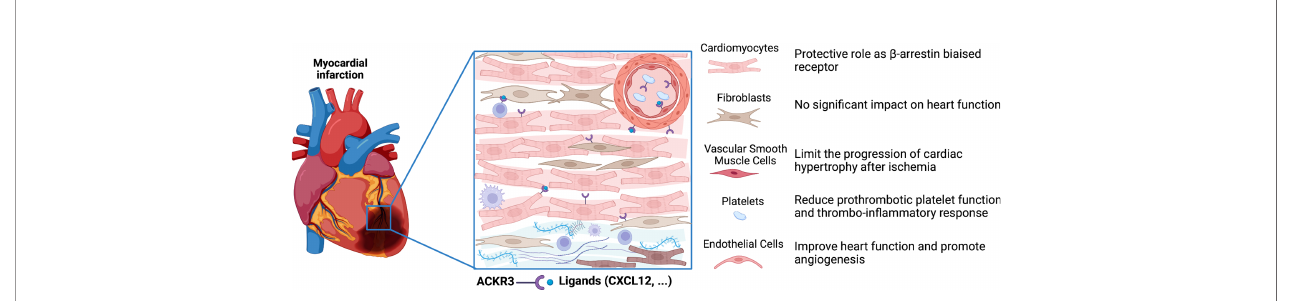
FIGURE 2 | Role of ACKR3 in the infarcted heart. ACKR3 expression is increased in several cells of the heart following myocardial infarction, and can play multiple roles after activation by endogenous and exogenous ligands. ACKR3 exerts cardioprotective effects by acting either as a rheostat for certain ligands through scavenging activity or as a co-partner through dimerization with other receptors. In addition, ACKR3 may trigger activation of b -arrestin-dependent pathways. (Figure created with